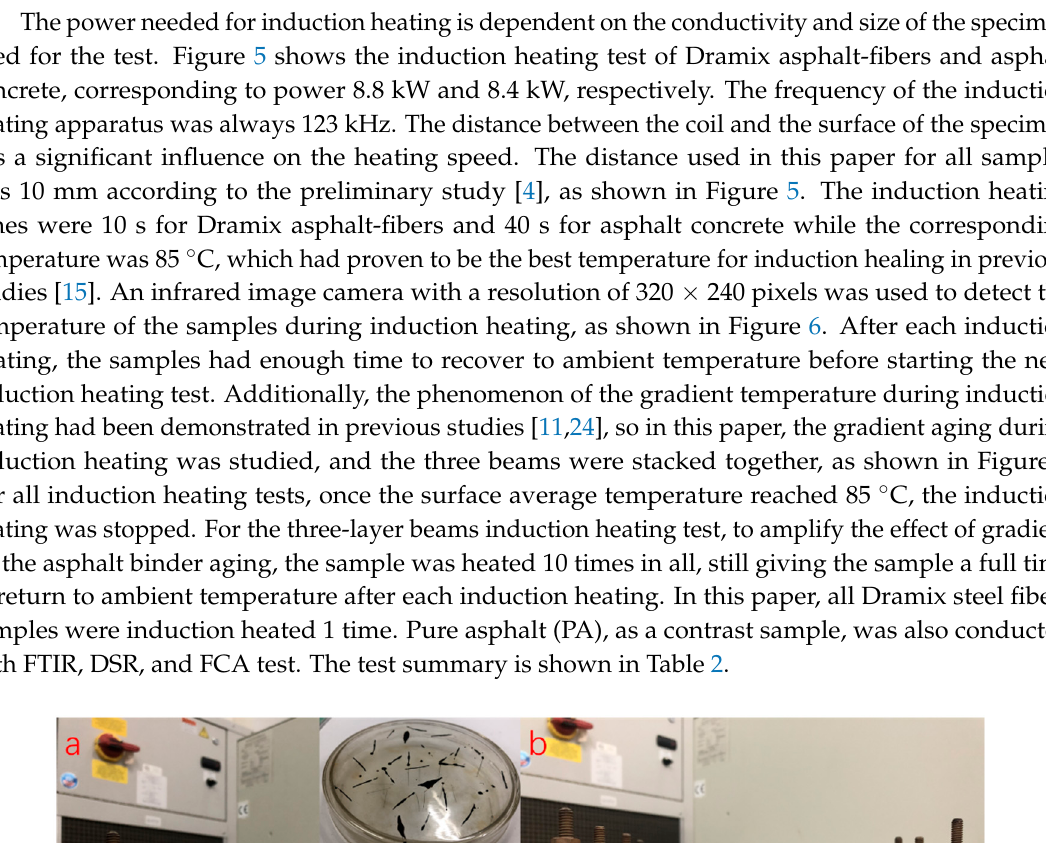
Figure 4. Induction heating test samples.